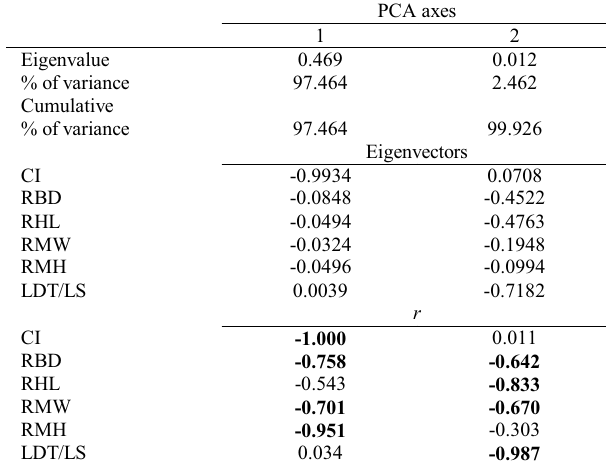
Table 5. Eigenvalues, eigenvectors, and variance extracted for the two principal axes of PCA. The correlation index values in bold type ( i.e. , > 0.6; negatives or positives) between each ecomorphological attribute and the correspondent axis were used to interpret the distribution of the four serranid species in the graphic of PCA (see Fig.